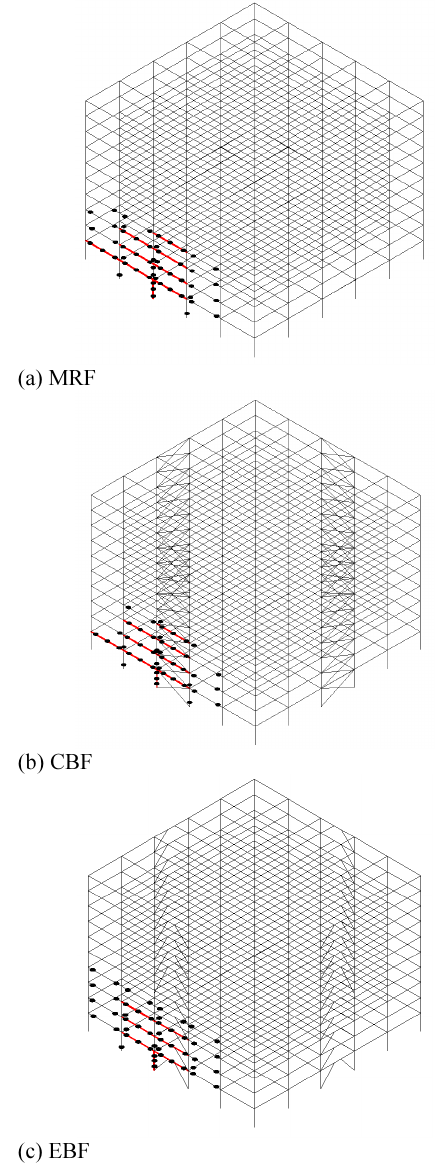
Fig. 11. Plastic hinge locations in MRF, CBF, EBF under a 4-K2-K (17.8 kN) blast (failed member are indicated by a thick line)